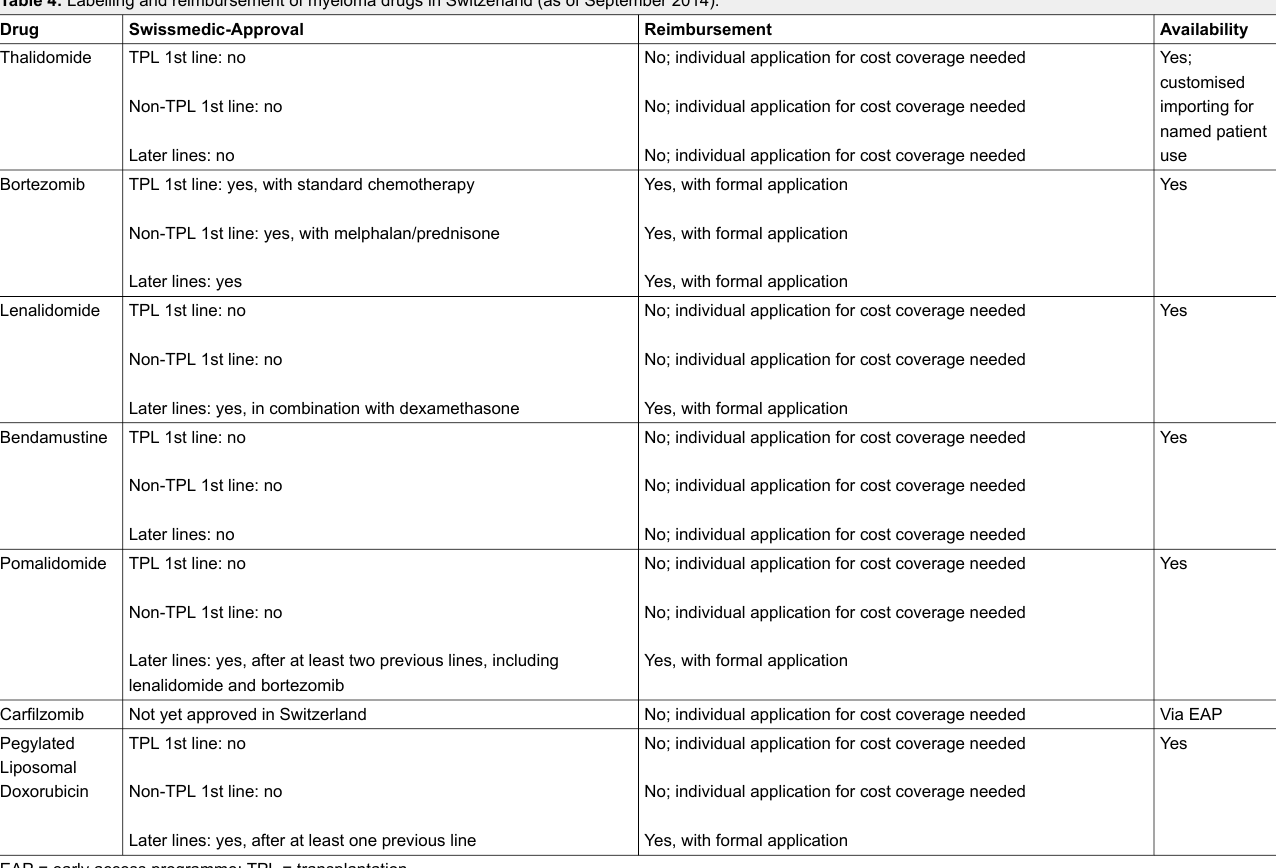
Table 4: Labelling and reimbursement of myeloma drugs in Switzerland (as of September 2014). Drug Swissmedic-Approval